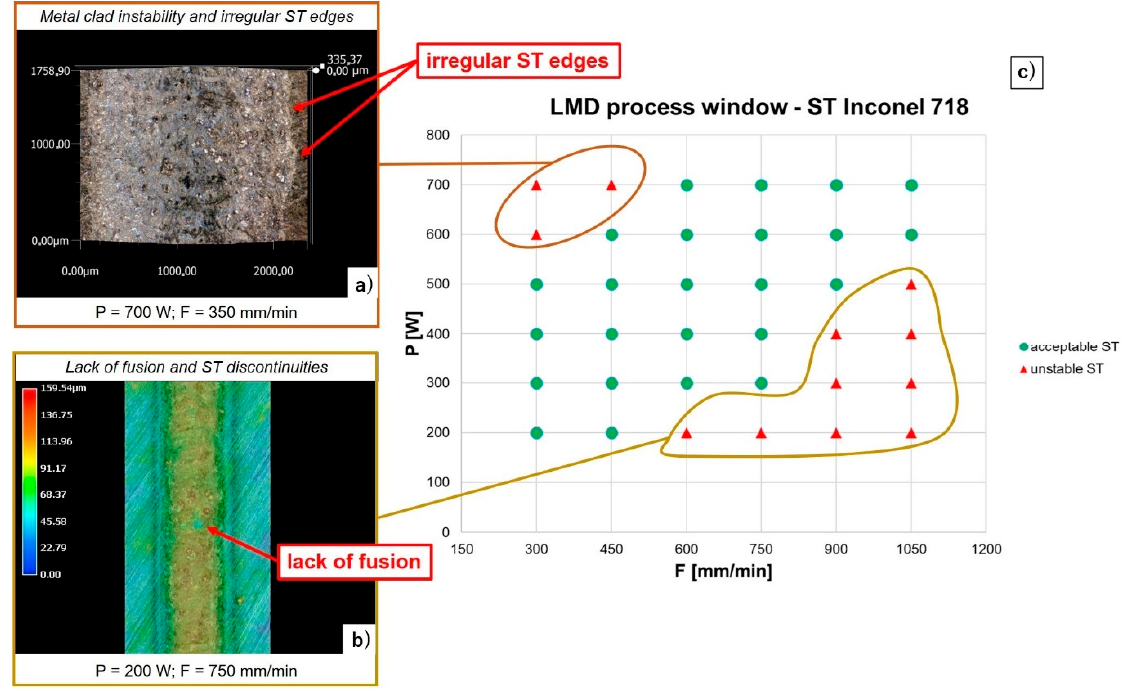
Figure 8. LMD process window for Inconel 718 STs: ( a ) irregular ST edges due to metal clad instability; ( b ) lack of fusion; ( c ) ST results and